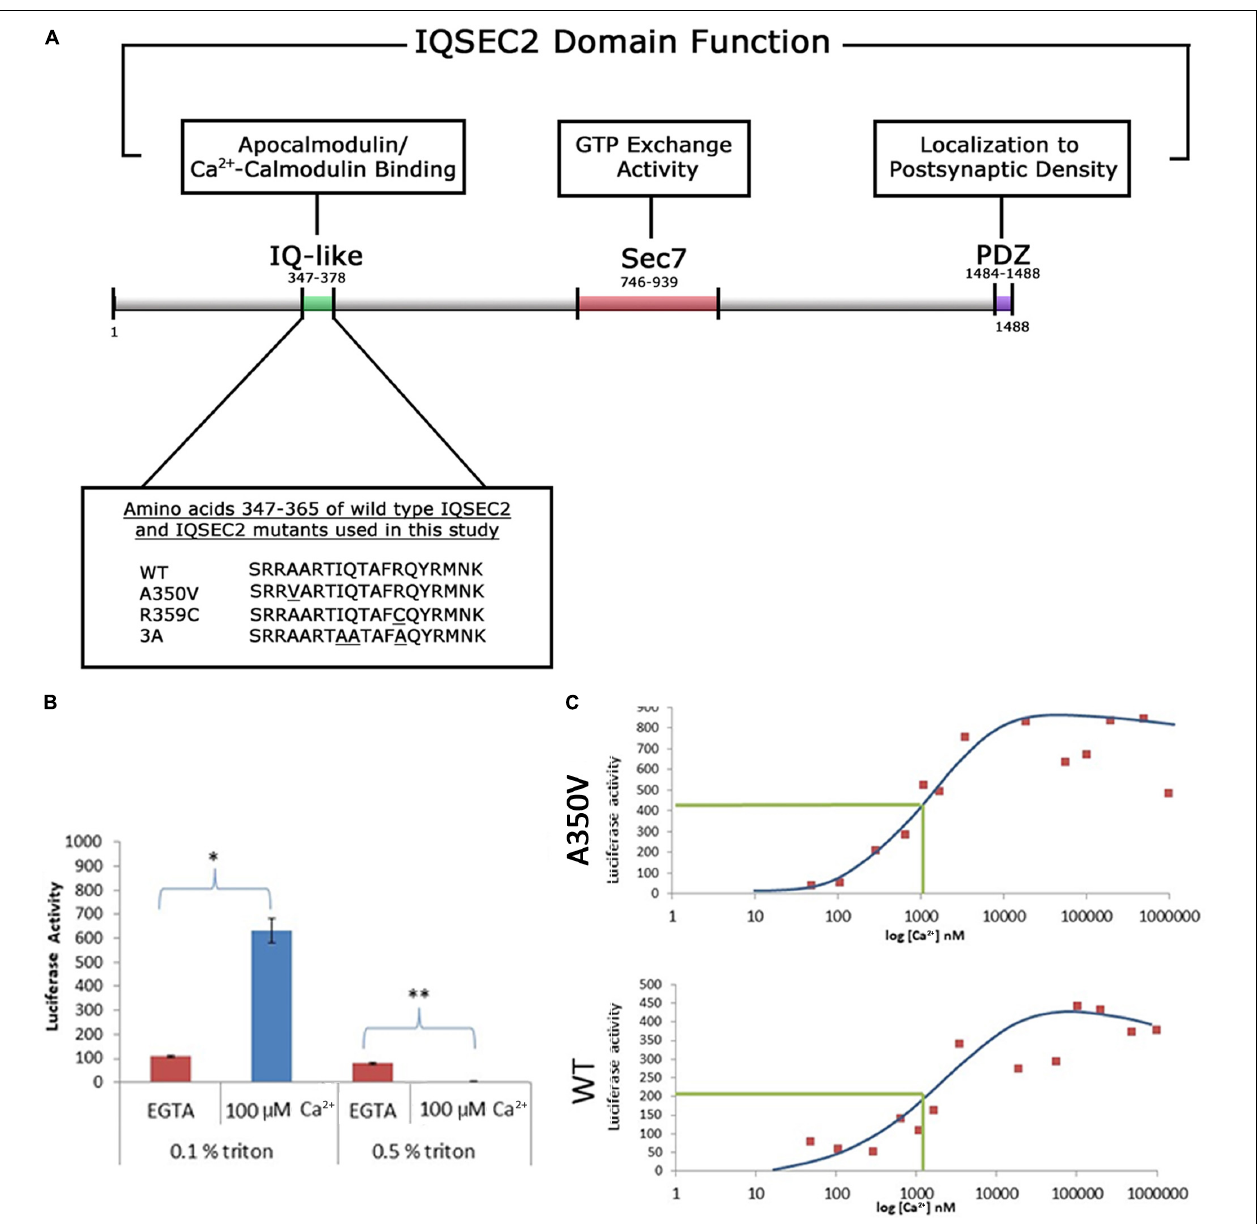
FIGURE 1 | (A) Functional domain organization of the IQSEC2 gene and amino acid sequence of IQSEC2 IQ motif mutants used in this study. IQ-like, IQ homology motif thought to be site for interaction of IQSEC2 with calmodulin (Shoubridge et al., 2010). SEC7, catalytic domain responsible for the GEF activity of IQSEC2 (Shoubridge et al., 2010). PDZ, domain reported to mediate interaction of IQSEC2 with the post-synaptic protein PSD-95 thereby localizing IQSEC2 to the post-synaptic density (Brown et al., 2016). Inset demonstrates the amino acid sequence within the IQSEC2 IQ domain of wild type IQSEC2 and sequence variants in this region, including A350V, used in this study. Underlined residues indicate site of sequence variance from the wild type. (B) The effect of calcium on the binding of IQSEC2 to calmodulin depends on the triton concentration in the cell extracts. Luciferase activity of the CM sepharose beads was used as a readout of the calmodulin IQSEC2-luciferase interaction. 293T cell extracts containing wild type IQSEC2 were prepared in low (0.1%) or high (0.5%) triton and used for binding studies with calmodulin sepharose as described in methods. In the presence of low triton concentration in the extracts, calcium resulted in a significant increase in the interaction between calmodulin and IQSEC2 (indicated by ∗ , unpaired t -test, p < 0.001, n = 6), while in the presence of high tritron calcium resulted in a significant decrease in the interaction between calmodulin and IQSEC2 (indicated by ∗∗ , unpaired t -test, p < 0.001, n = 6). (C) The binding of calmodulin to wild type and A350V IQSEC2 is increased by calcium. Cell extracts containing wild type or A350V IQSEC2 and binding studies between IQSEC2 and calmodulin sepharose under defined calcium concentrations were performed as described in methods. As shown for a representative experiment for both wild type and A350V IQSEC2, calcium resulted in an increase in binding of calmodulin to IQSEC2 with a similar calcium dose-response relationship [half-maximal binding (indicated by green line) of calcium-calmodulin for IQSEC2 at a free calcium concentration of approximately 1 µ M for both wild type and A350V IQSEC2]. The binding of calcium calmodulin was significantly increased for A350V IQSEC2 as compared to wild type IQSEC2 at all calcium concentrations greater than 200 nM (A350V 594 ± 59.6 vs. wild type 271 ± 41 luciferase units, n = 11, unpaired t -test, p < 0.0005).